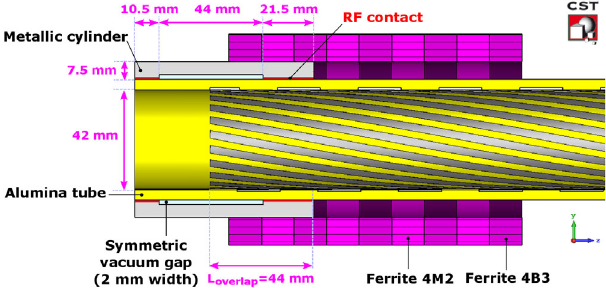
FIG. 19. CST model of a prototype helical beam screen installed in the LHC MKI.